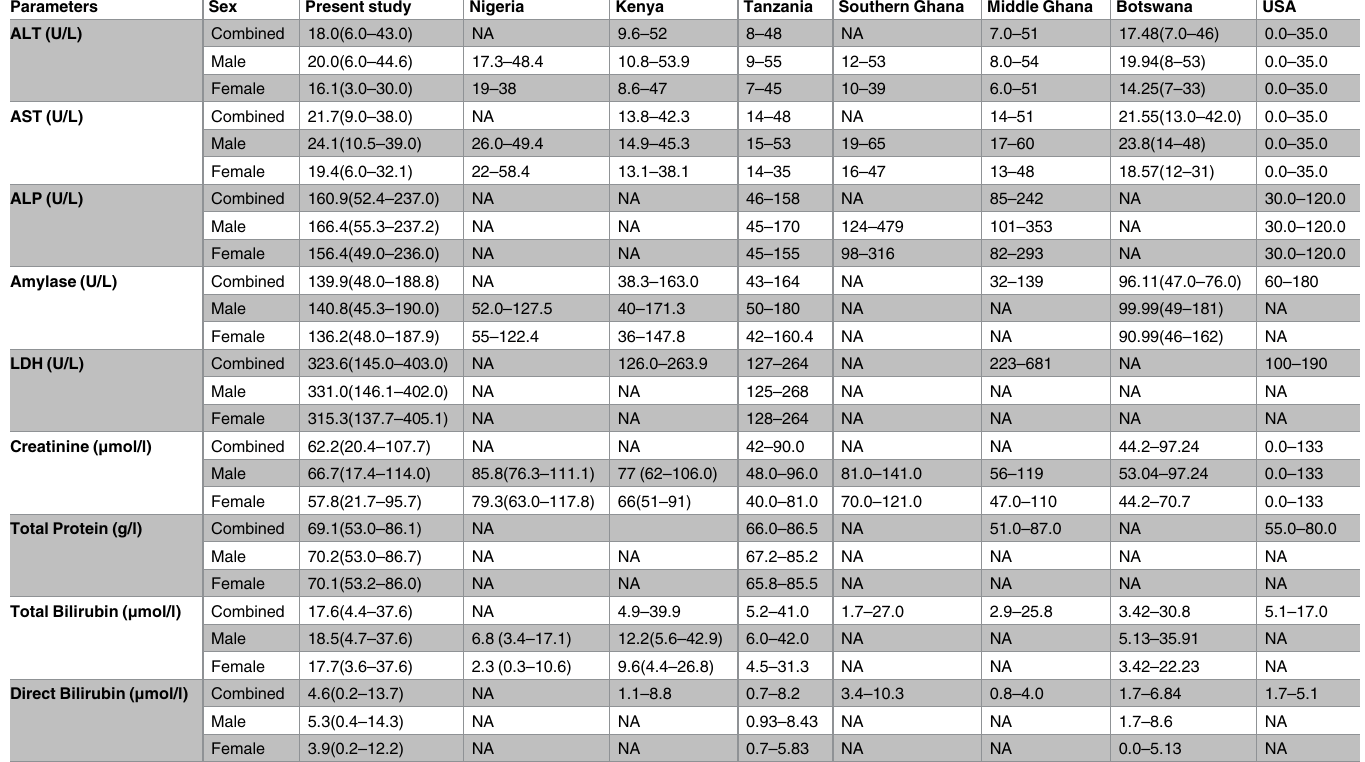
Table 7. Comparison of reference range values of clinical chemistry parameters of the present study with other studies in African and western countries.